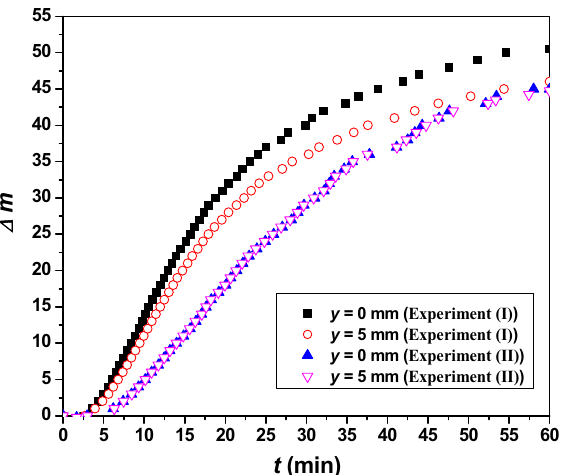
Figure 5. Δm as a function of t for toluene under the two conditions of the UV 254 exposure for the points y = 0 mm and y = 5 mm.